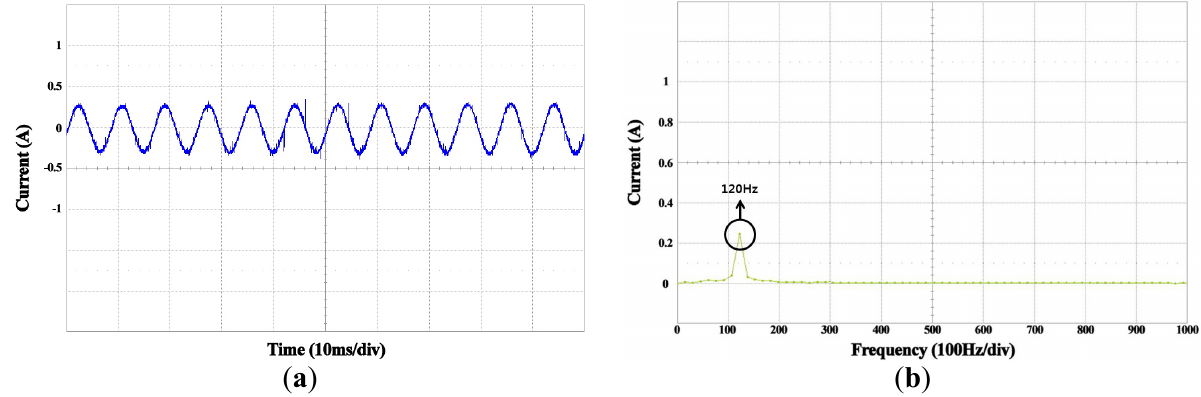
Figure 23. Magnitude of the second-order harmonic component. ( a ) Time domain; ( b ) frequency domain.